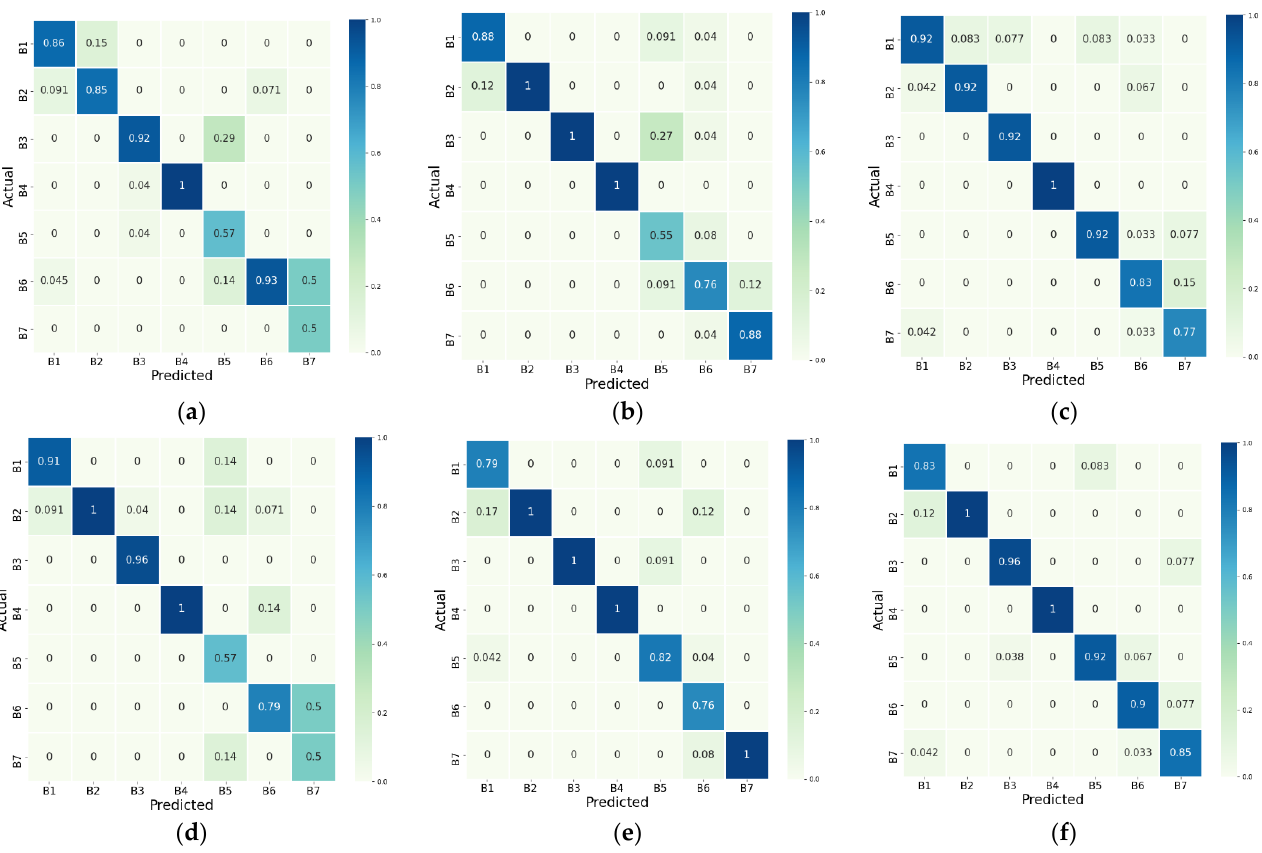
Figure 10. Confusion matrix of behavior recognition by fusion models based on multimodal data: ( a ) Only concatenate model with FasterRCNN; ( b ) Only concatenate model with YOLOv3; ( c ) Only concatenate model with YOLOv4; ( d ) CNN-LSTM model with FasterRCNN; ( e ) CNN-LSTM model with YOLOv3; ( f ) CNN-LSTM model with YOLOv4. Table 7. Results of behavior recognition performance evaluation by fusion models based on multi- modal data.